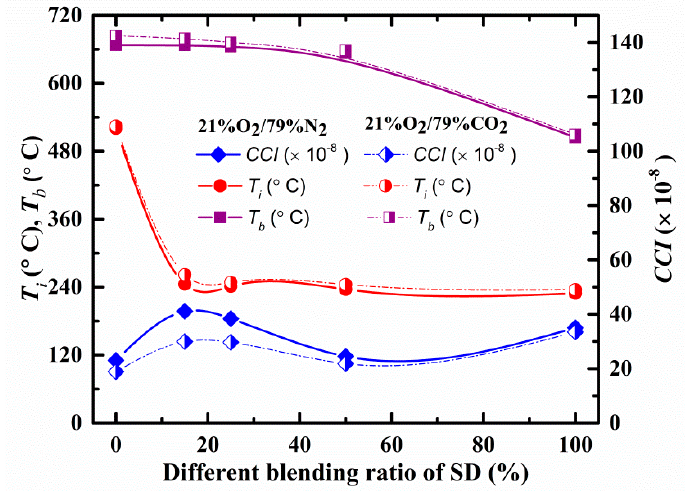
Figure 3. Ignition and burnout temperature and CCI at different mixed proportions and combustion